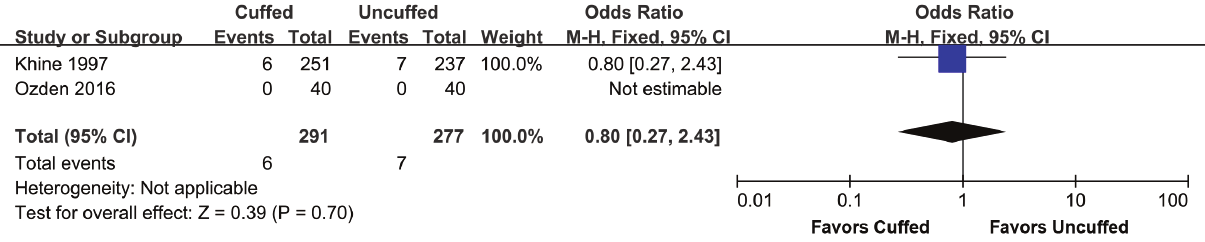
Supplemental Figure 5: The meta-analysis of croup between cuffed and uncuffed groups.